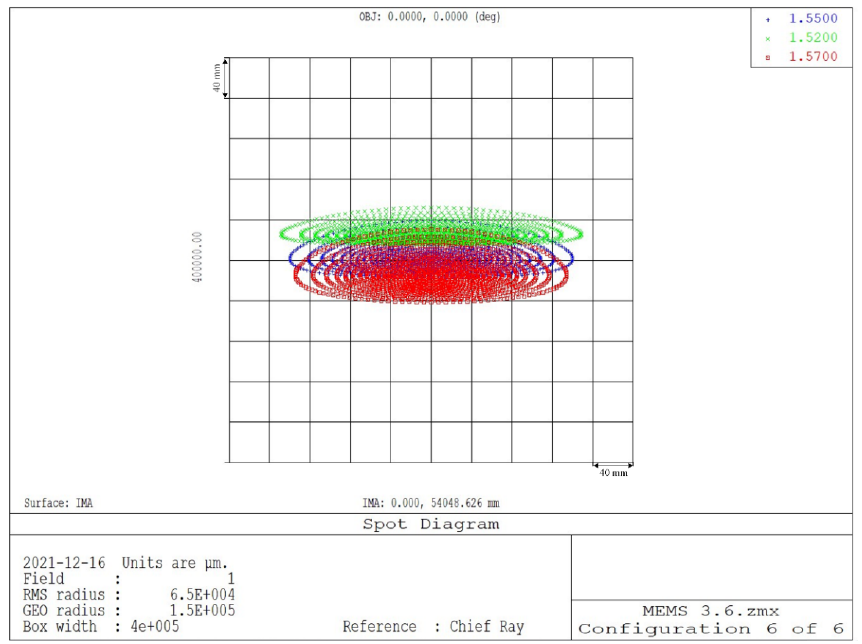
Figure 10. Spot diagrams at 5°.